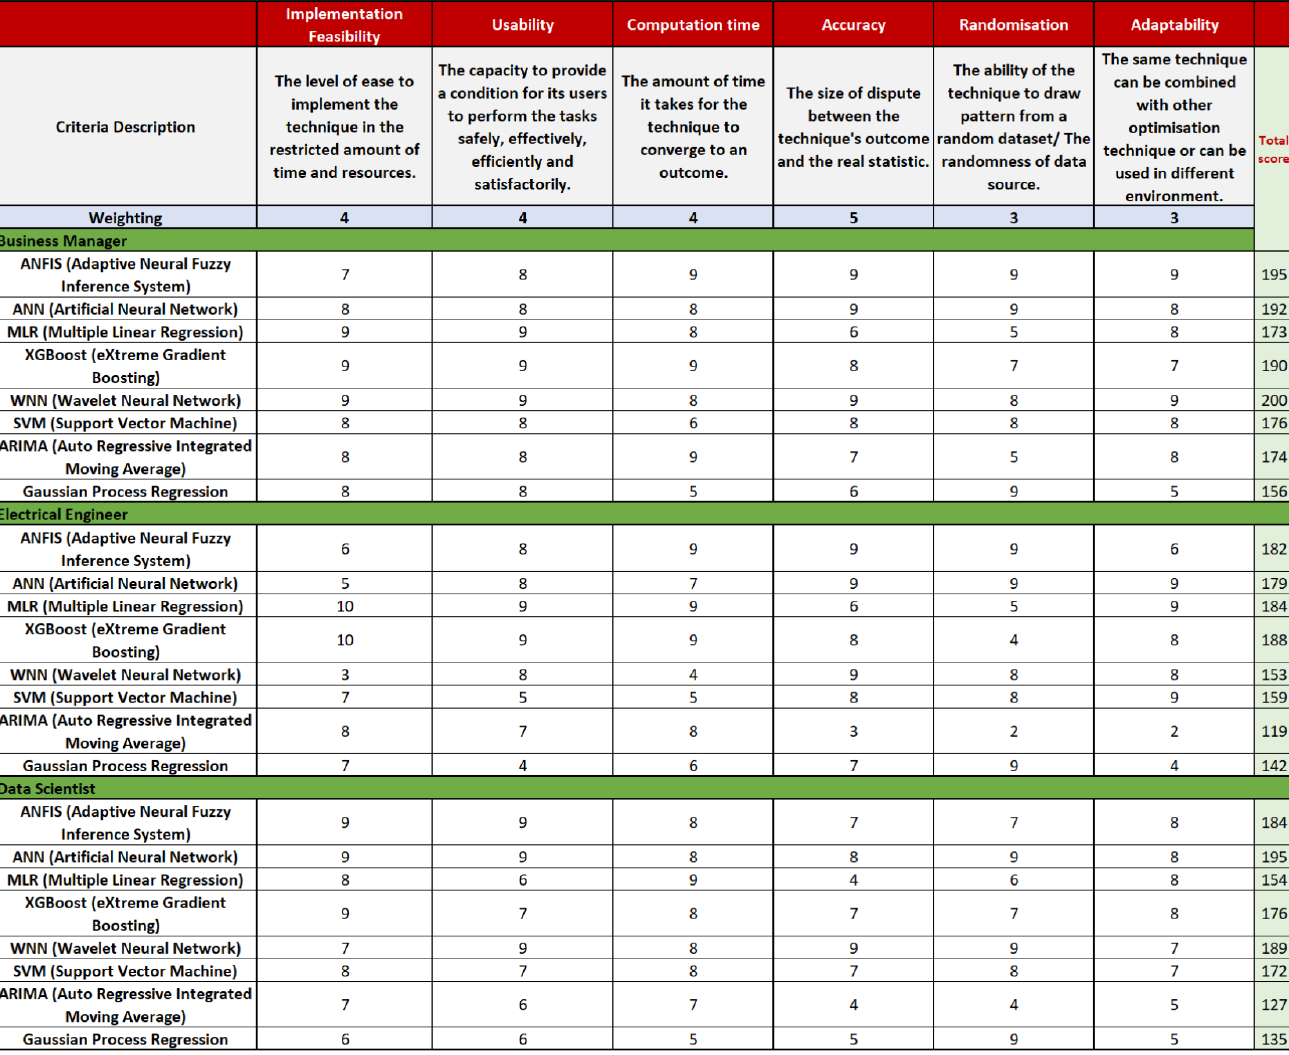
Figure 2. MCA matrices and scoring